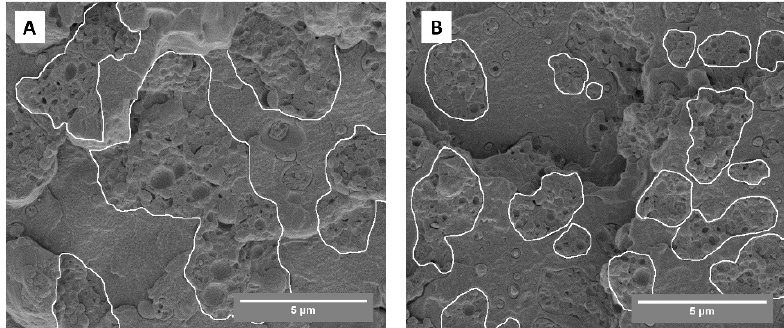
Figure 6. SEM images of PTT / ABS blends ( A ) without and ( B ) with compatibilizing agent.